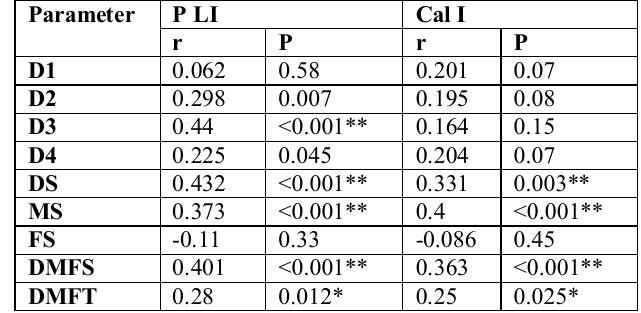
Table 4: Relation of dental caries with oral cleanliness for pregnant women. Parameter